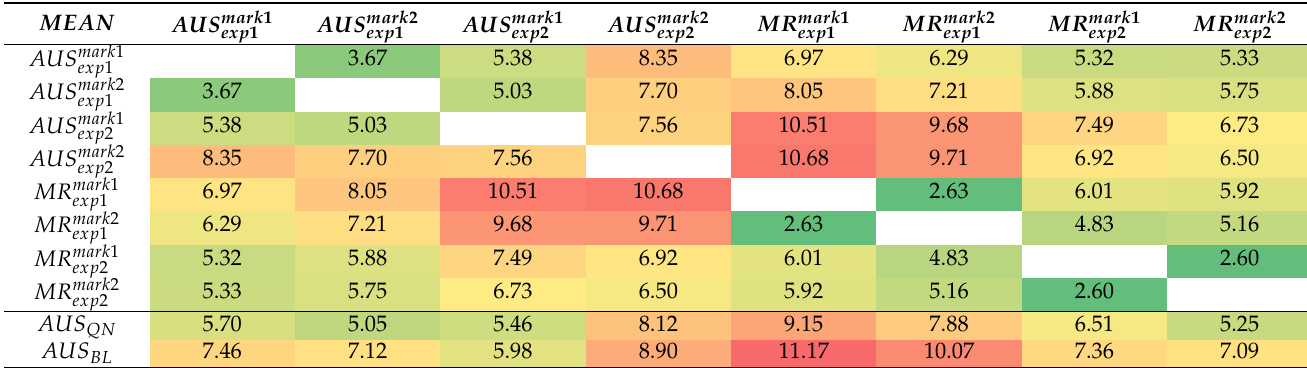
Table 2. The corresponding SDAVD values of Table